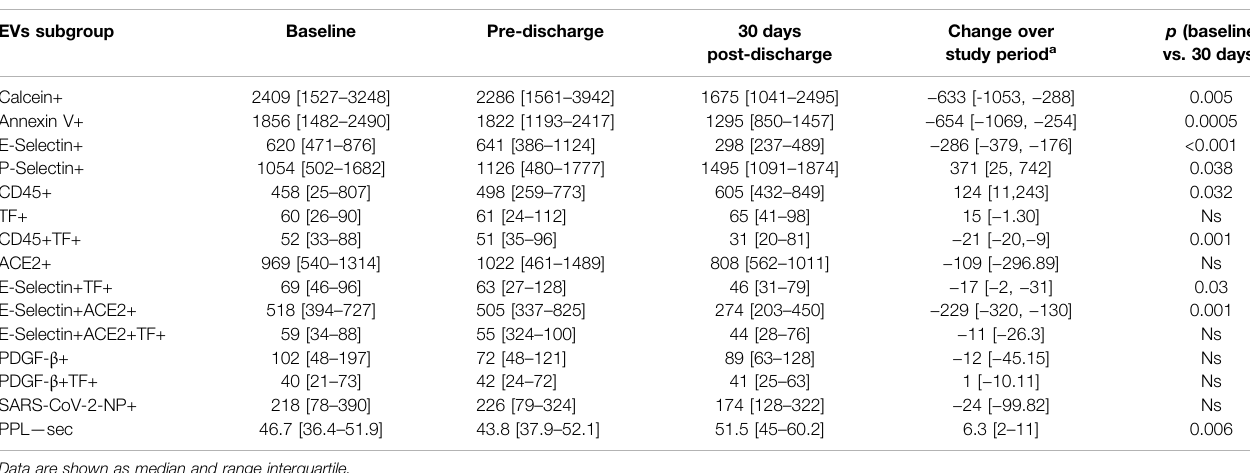
Frontiers in Cell and Developmental Biology |